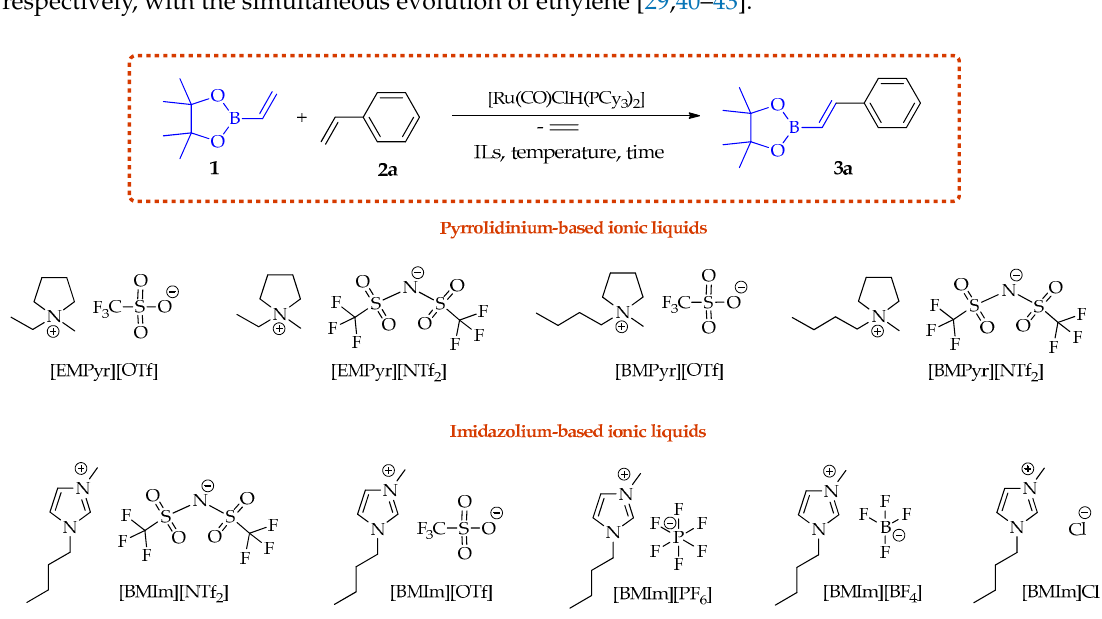
Figure 1. Model reaction of 1 with 2a used for the conditions screening. Pyrrolidinium and imidazolium-based ionic liquids used as solvents and catalyst immobilization media.